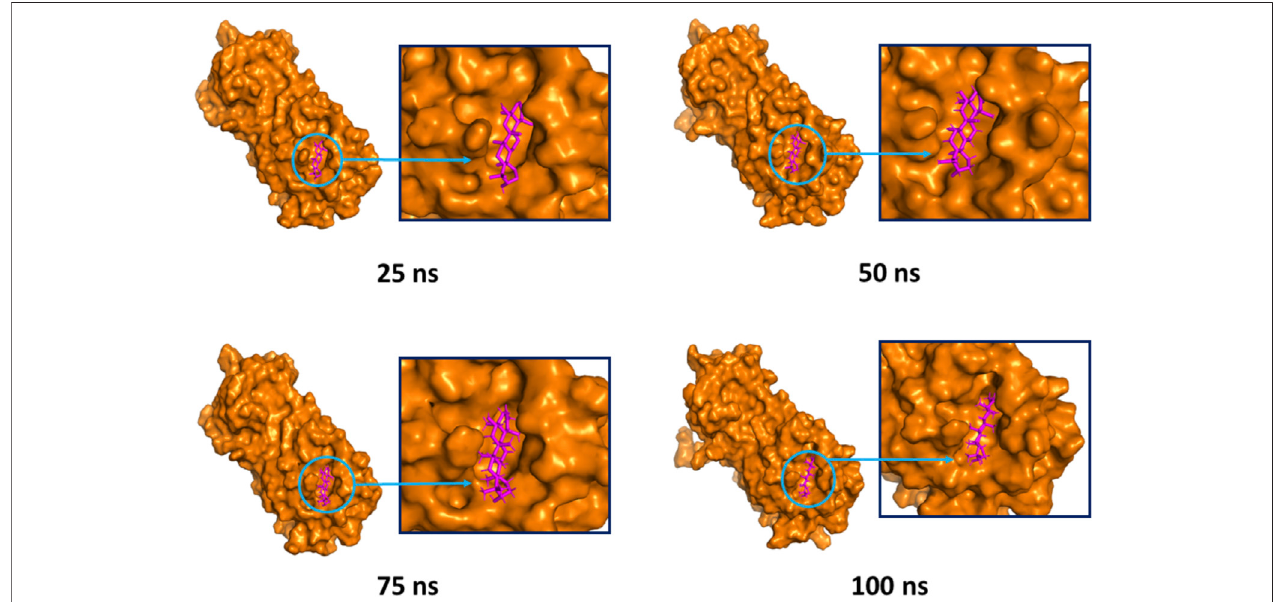
FIGURE 9 | The surface view of the docked fl avanthrin and M pro complex, shown as 25, 50, 75, and 100 ns snapshots. The binding pose and interactions were remained in the same binding pockets. The fi gure were generated from Pymol software package.